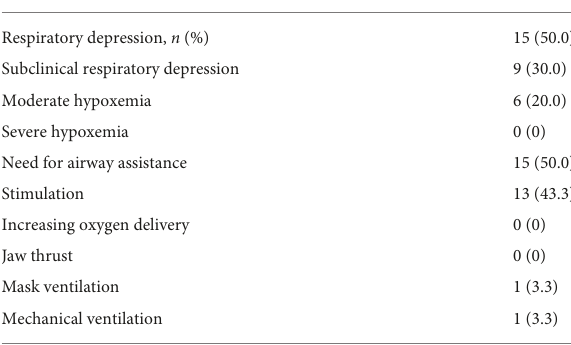
TABLE 5 Incidence of hypoxemia and need for airway assistance ( n =